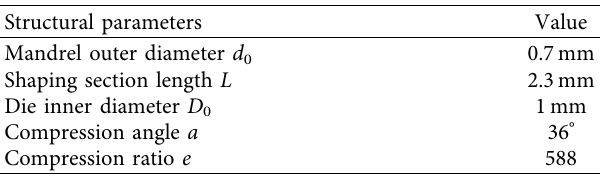
Figure 2: Schematic diagram of microtube mold fow channel. Table 1: Flow channel structure parameter of microtube extrusion die.